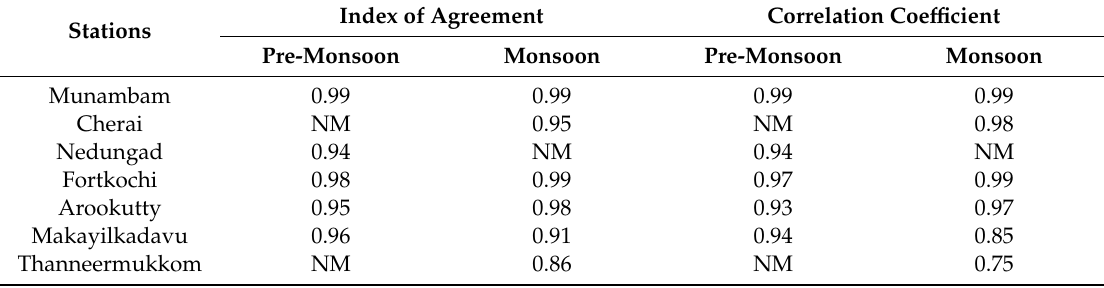
Table 2. The index values and correlations of the predicted / simulated time series surface water elevations at seven locations in CE during pre-monsoon (2010) and monsoon